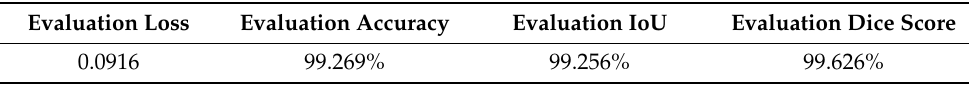
Table 4. The results of the (fully annotated) evaluation images for the transfer learning. Evaluation Loss